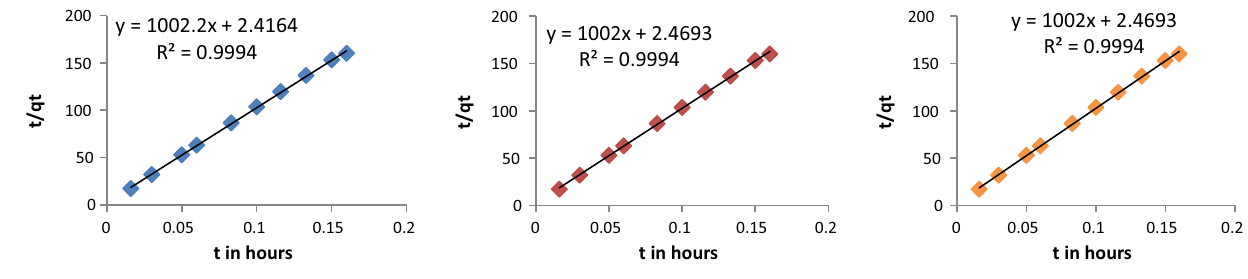
Fig. 7 Pseudo-second-order kinetic model for the removal of Cu(II) using GNSCP, SSCP and CCP